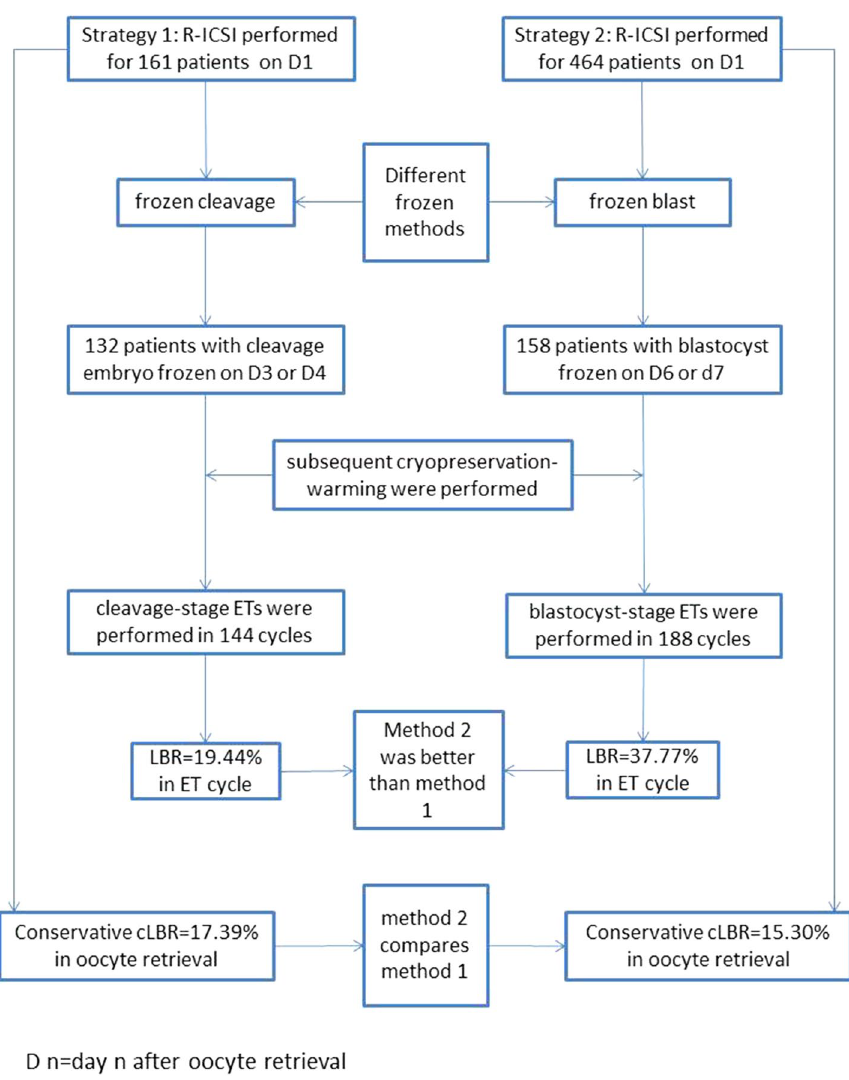
Figure 1. Flow chart and outcomes of method 1 and method